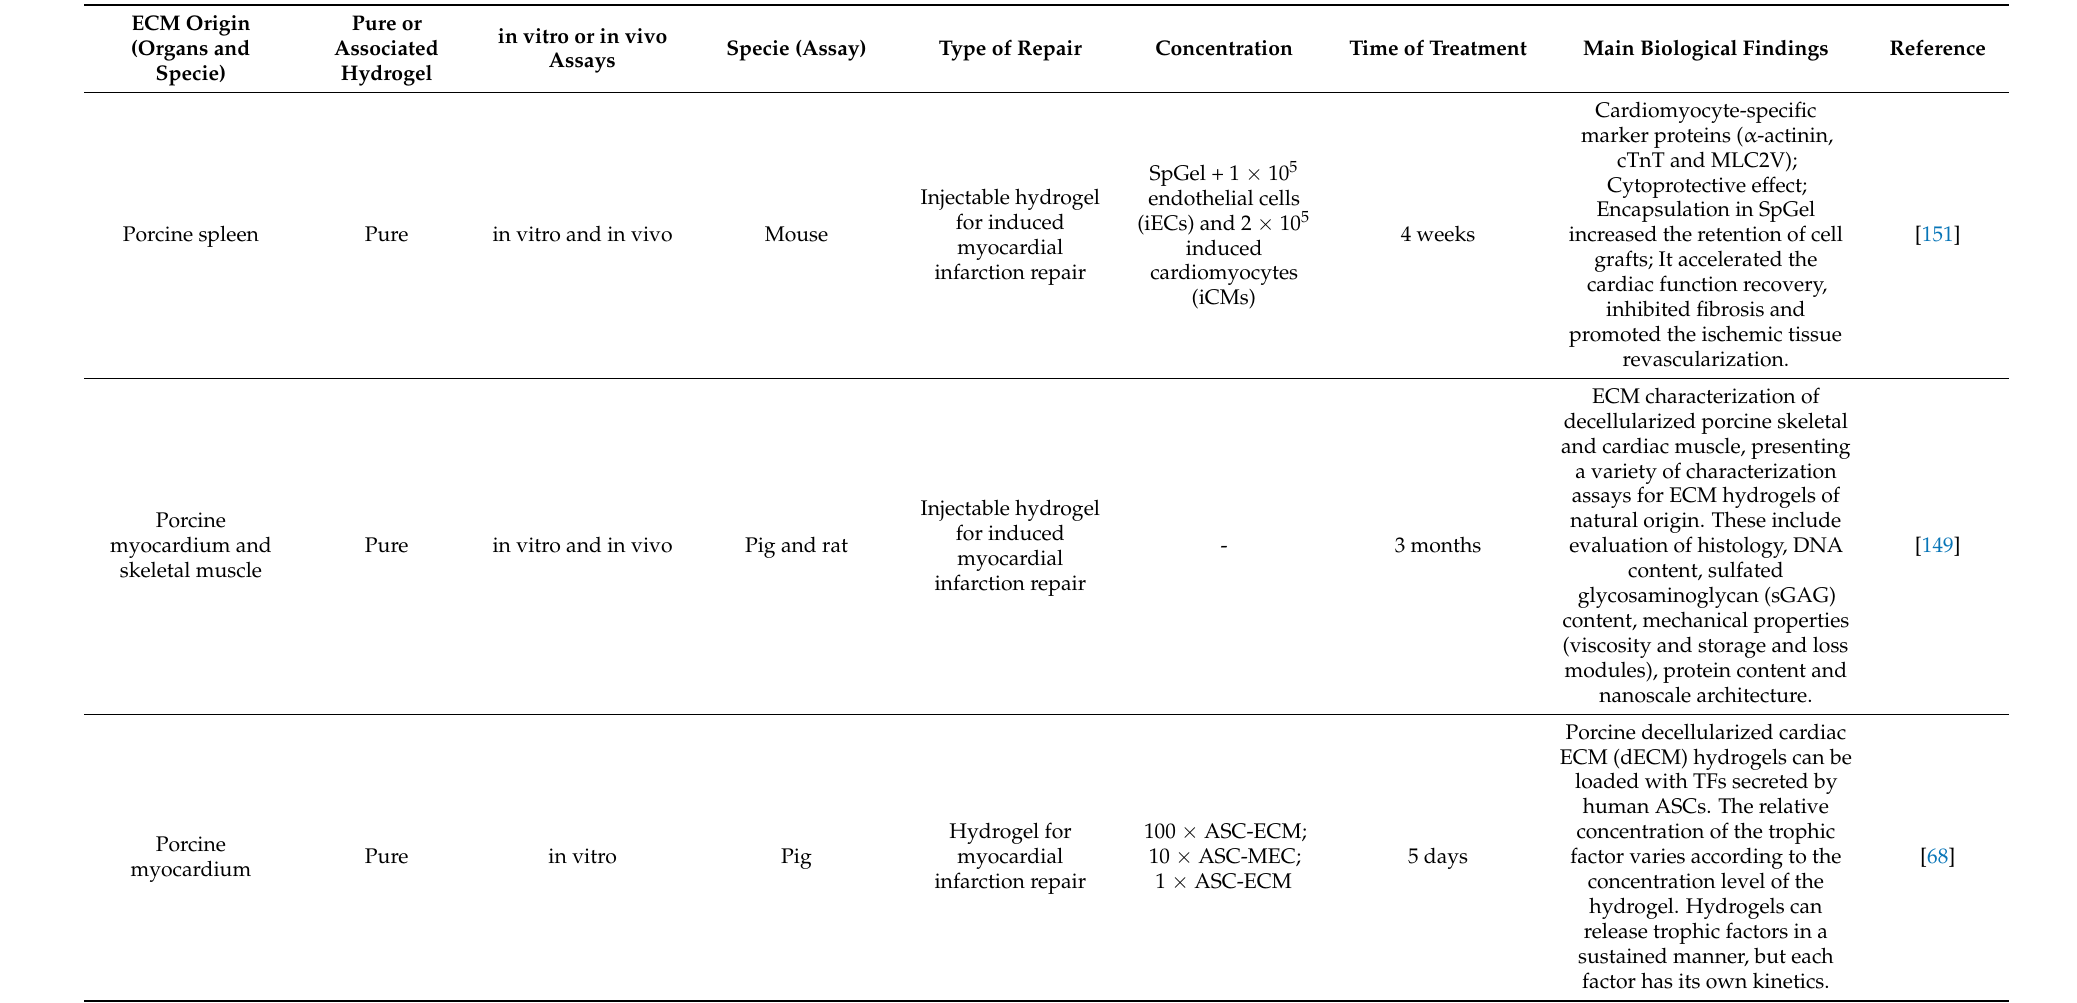
Table 1. Types of extracellular matrix-derived hydrogels applied in vitro and/or in vivo cardiac